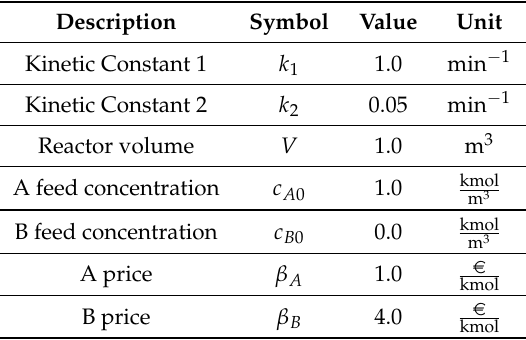
Table 1. Actual reactor